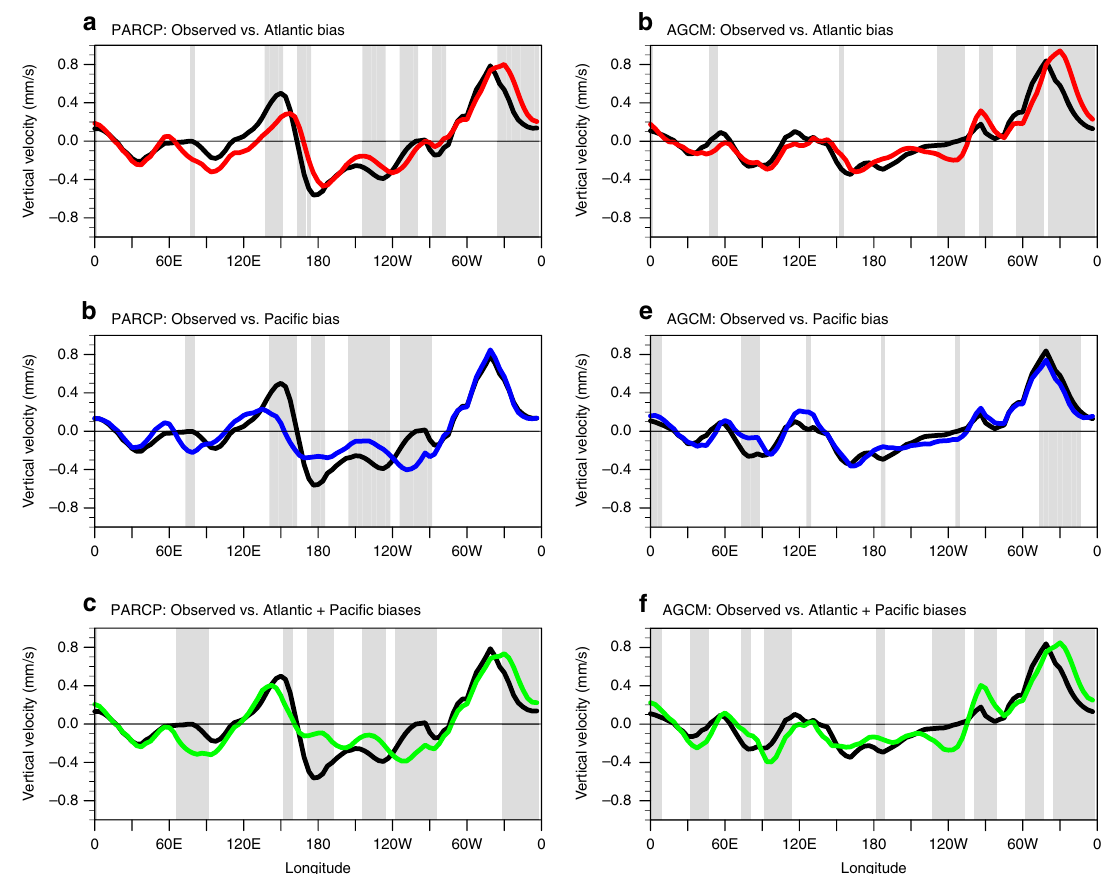
Fig. 2 Vertical velocity response in coupled and atmosphere-only simulations. a – c The averaged equatorial (15°S – 15°N) vertical velocity (1000 – 200 hPa) response (unit: mm s − 1 ) to the Atlantic warming in the partially coupled (PARCP) simulations. The black lines represent the response under observed mean state. The red, blue and green lines represent the result from Atlantic bias, Paci fi c bias and combined Atlantic and Paci fi c bias simulations, respectively. The grey shading indicates the differences between the bias and unbiased simulations are above 90% con fi dence level. d – f As in ( a – c ), but for the atmosphere-only (AGCM) simulations. Note the positive vertical velocity represents upward motion and vice versa.